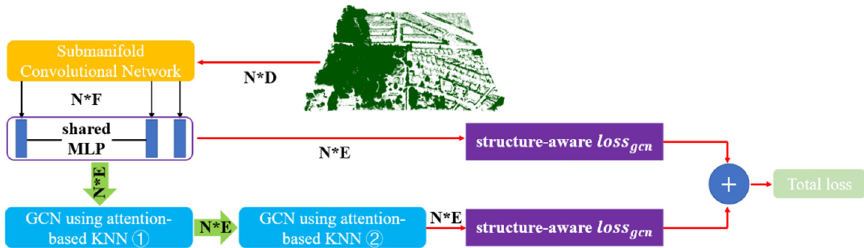
Figure 6. Illustration of the whole network architecture for individual tree segmentation. N is the number of points. F is the dimension of the backbone (submanifold convolutional network) output. E is the dimension of the instance embedding. The over-segmentation algorithm is used to cluster the instance embeddings during the inference.